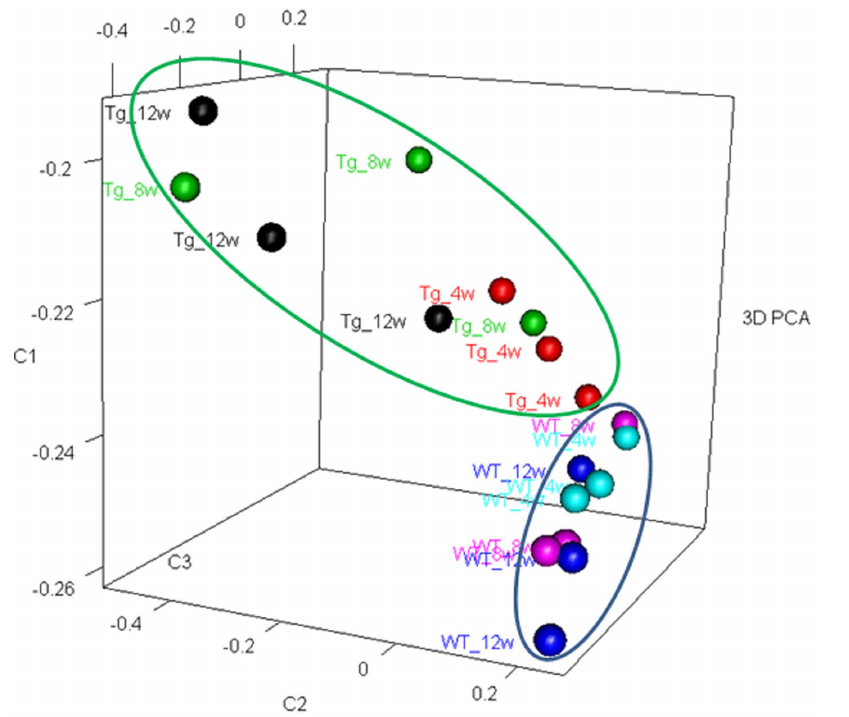
Figure 1. 3D snapshot of PCA analysis of samples distribution based on all the genes: The Tg26 samples were well separated from WT samples. Moreover, 8 wk and 12 wk Tg26 samples were farther away from WT samples than 4 w Tg26 samples, indicating dramatic transcriptomic changes in T26 mice after 8 weeks. doi:10.1371/journal.pone.0093019.g001 PLOS ONE |